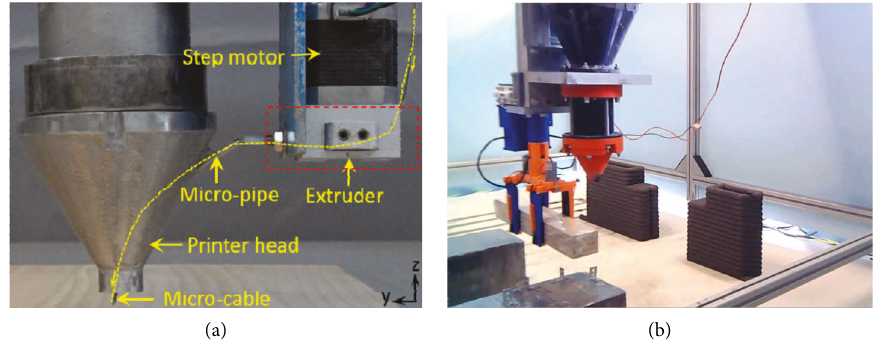
Figure 10: Sprinkler head device feeding mechanism (a) [23] and sprinkler head device manipulator (b)